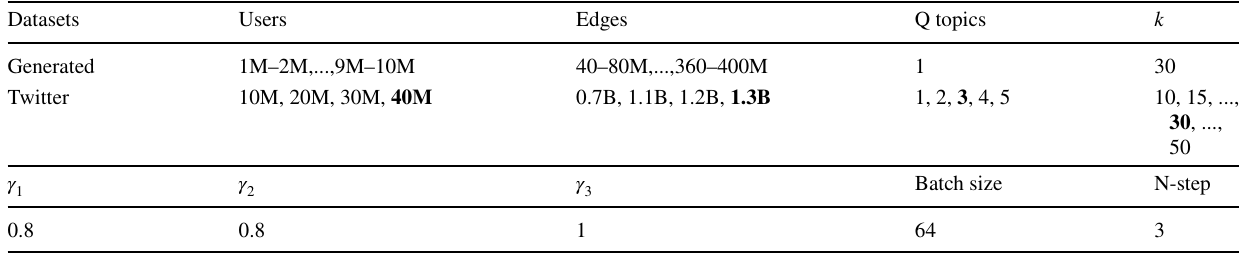
Table 3 Main configurations used in experiments with default values highlighted Datasets